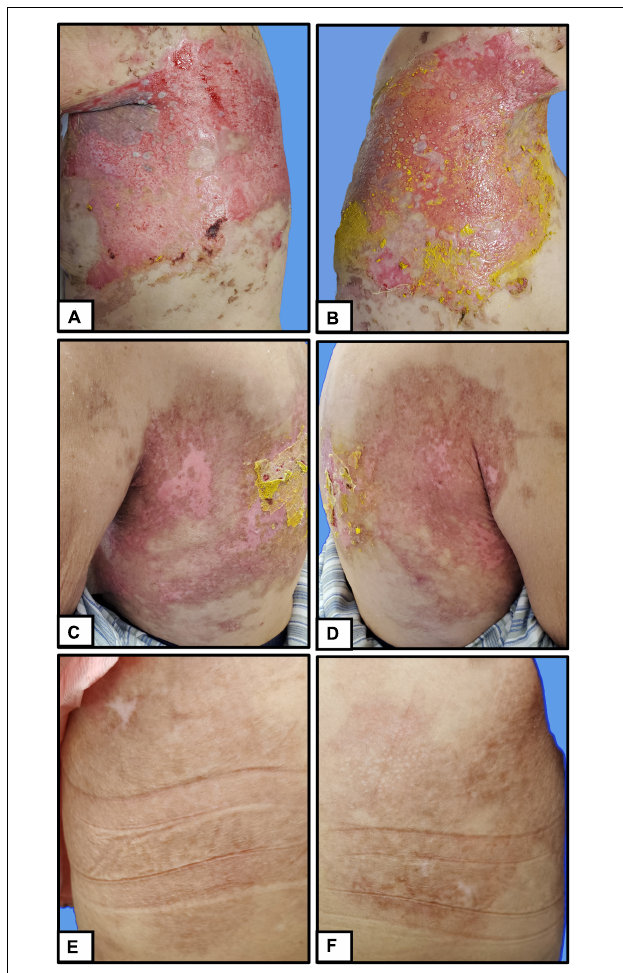
FIGURE 3 | Clinical manifestations of patients with pemphigus. (A,B) Before treatment, (C,D) 2 weeks after treatment, (E,F) during follow-up.